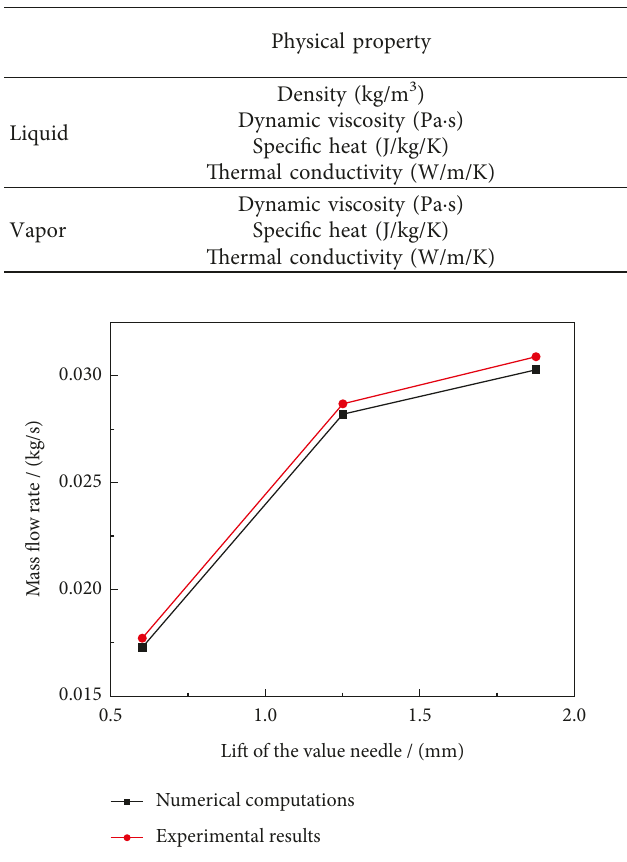
Figure 3: MFR versus the lift of the valve needle.